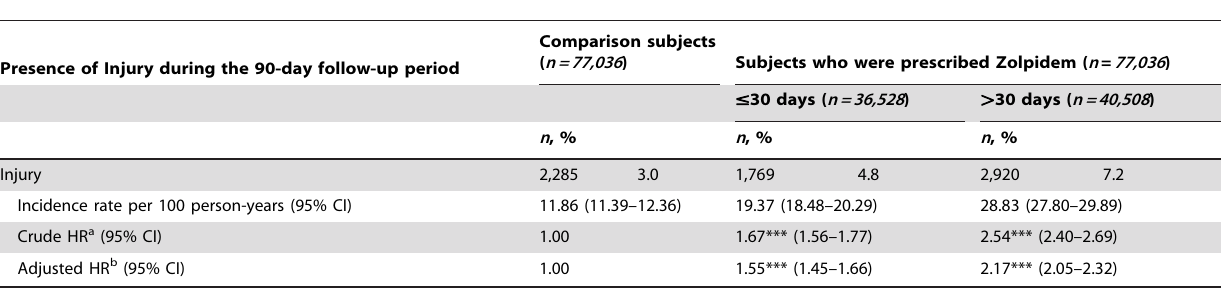
Table 3. Incidence rate, crude and adjusted hazard ratios for injury among the sampled subjects, by the length of Zolpidem treatment.